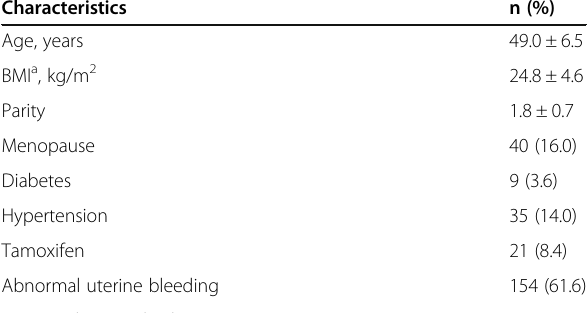
Table 1 Characteristics of the overall study population Characteristics